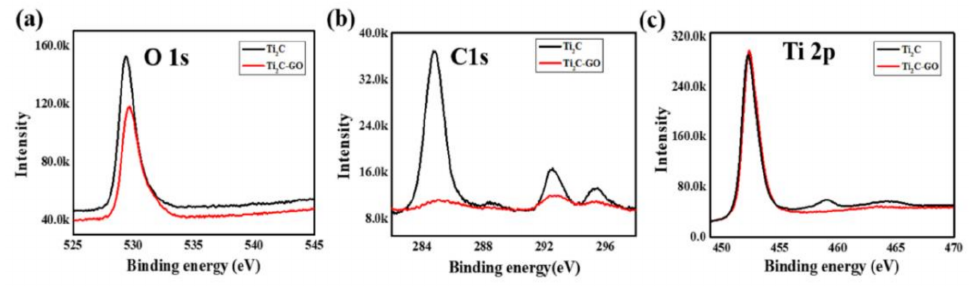
Figure 6. X-ray photoelectron spectroscopy (XPS) characterization of MXene and MXene–GO materi- als: ( a ) oxide element analysis; ( b ) carbon element analysis; ( c ) titanium element